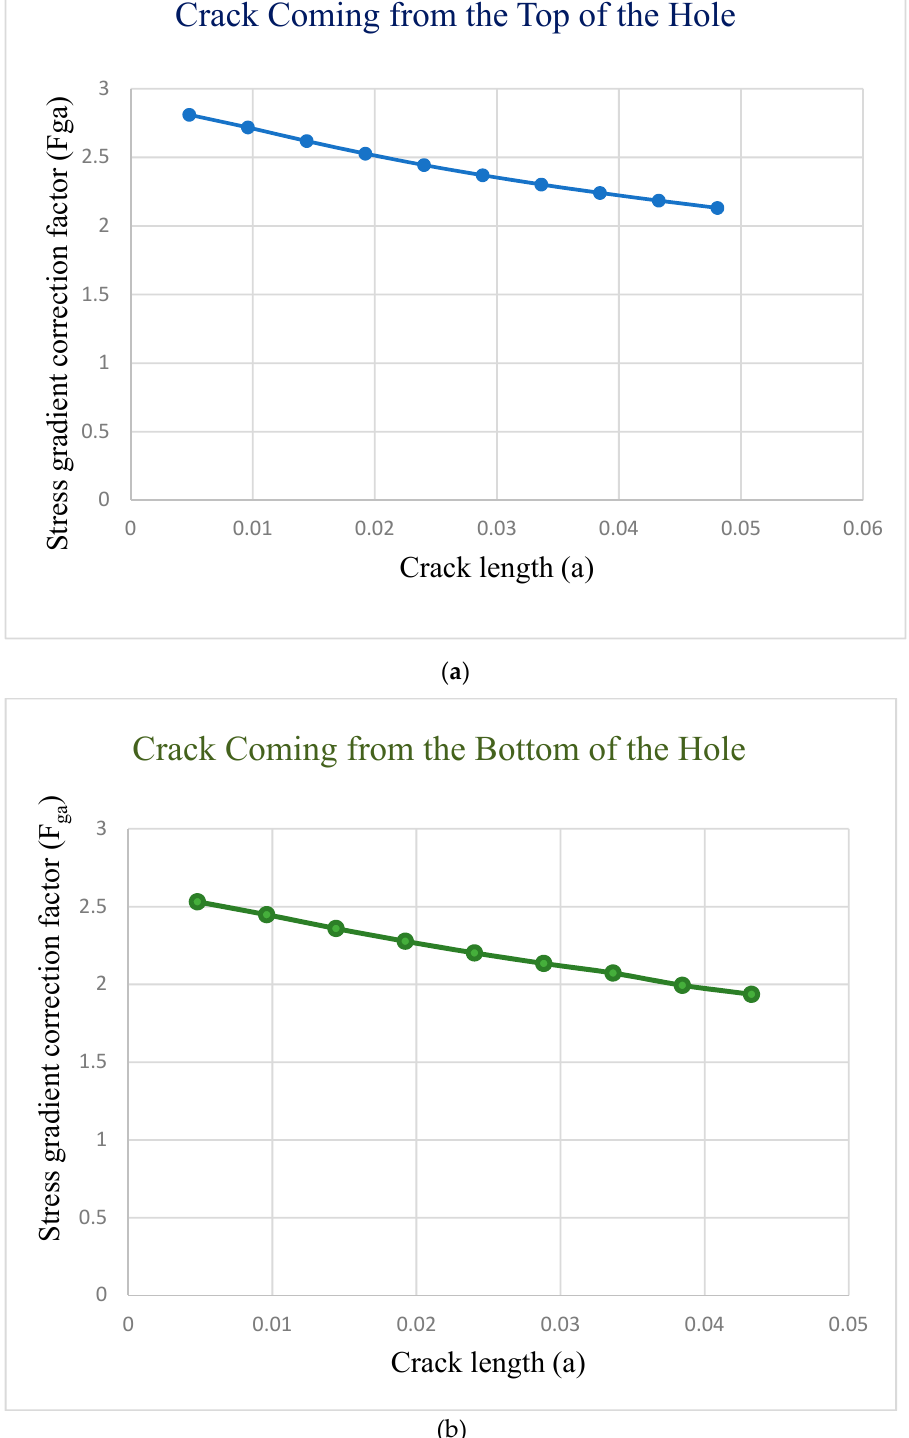
Figure 15. Relationship between crack length and stress gradient correction factor. ( a ) crack coming from the top of the hole; ( b ) crack coming from the top of the hole.